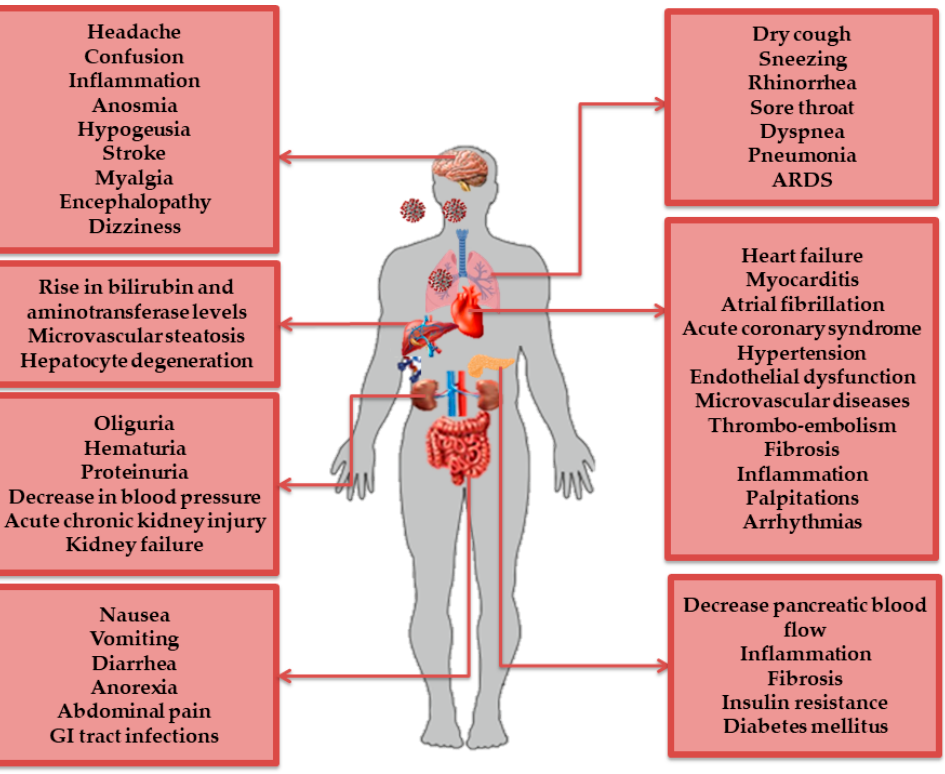
Figure 3. COVID-19 associated multiorgan diseases. ACE2 was found to be expressed in the lungs, the main entry route, as well as several tissues (including vessel endothelial and smooth muscle) and other vital organs (brain, heart, kidney, intestine, liver, etc.). Therefore, pulmonary manifesta- tions and extrapulmonary manifestations are marked in SARS-CoV-2 infection and are summarized in this figure. Organ dysfunction includes both direct SARS-CoV-2 cytotoxic effects and cytokine- mediated